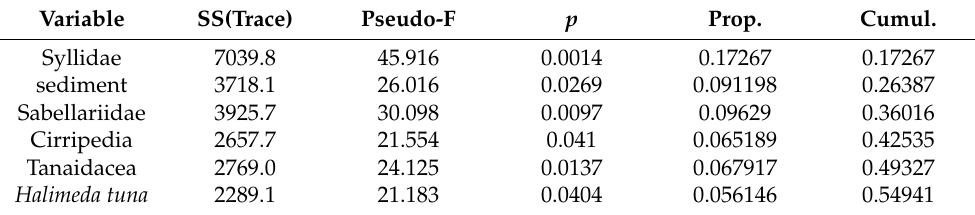
Table 5. DISTLM-forward analysis. Only predictor variables significantly related to the assemblages in the sequential test are reported. SS(trace) = Sums of squares, Pseudo-F = statistics, p = signif- icance, Prop = significant proportion of explained variation, Cumul = cumulative proportion of explained variation. Variable SS(Trace) Pseudo-F p Prop. Cumul. Syllidae 7039.8 45.916 0.0014 0.17267 0.17267 sediment